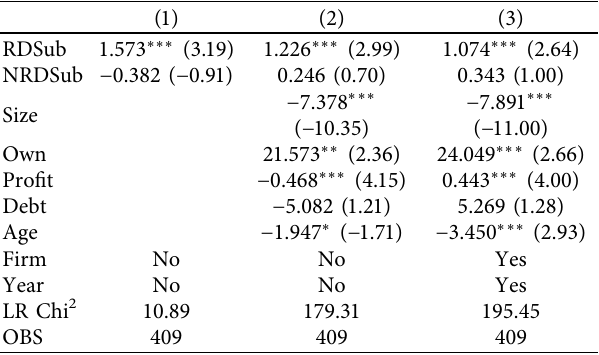
Table 4: Estimates of the effects of government subsidies. Table 5: Robustness